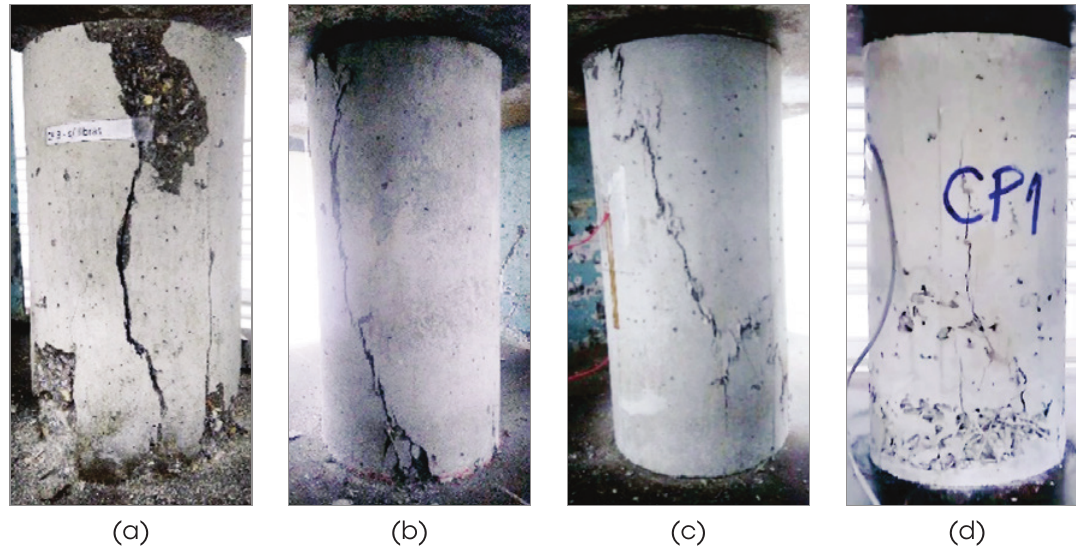
Specimens after compression tests: (a) plain, (b) with 1% fibers (25 mm), (c) with 2.5% fibers (25 mm) and 1% fibers (35